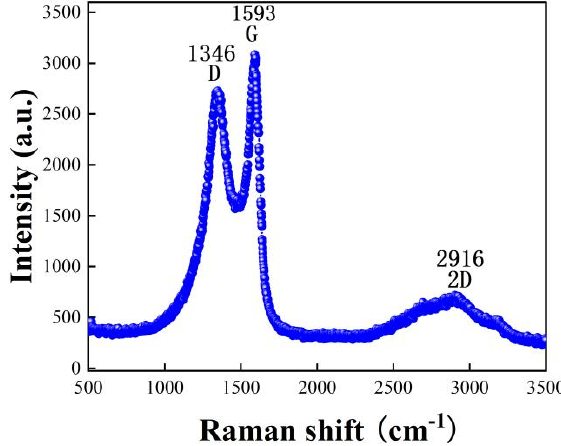
Figure 6. Raman spectra of rGO-SDS composite film.